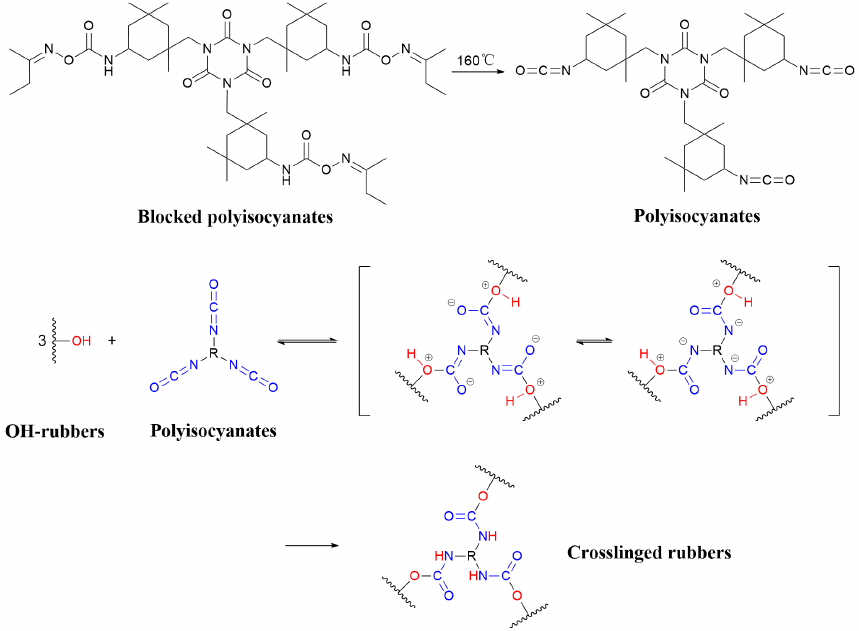
Figure 2. ( a ) FTIR spectra of BI, BROH 3 , and BROH 3 /BI compounds and BROH 3 /BI 6 vulcanizate and ( b ) curing profiles of BROH 3 /BI/silica composites at different curing temperatures.